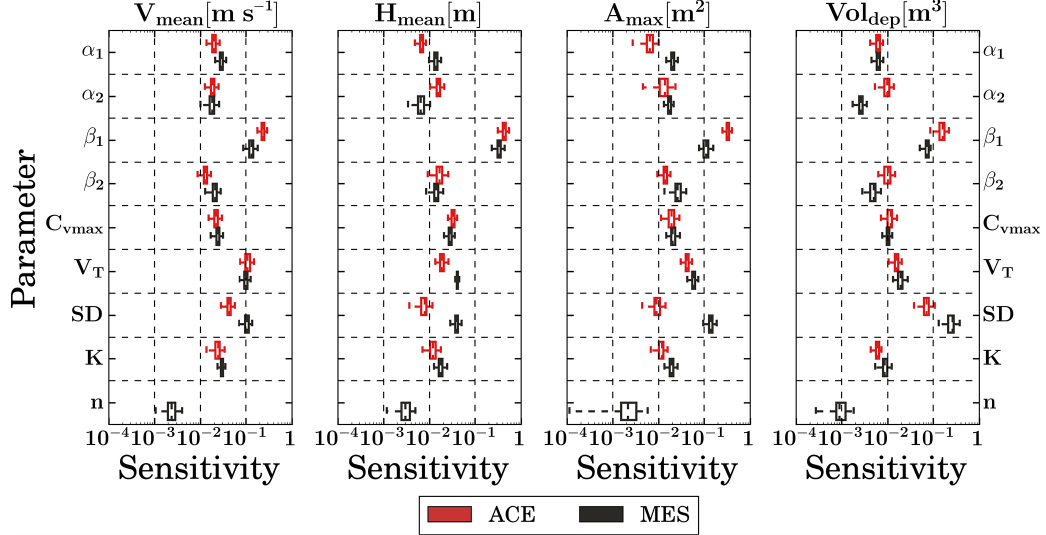
Figure 3. Effects of sample size N k on the cumulative distribution function (CDF) of DELSA indices for parameters β 1 (a) and C v the Acerillas creek.